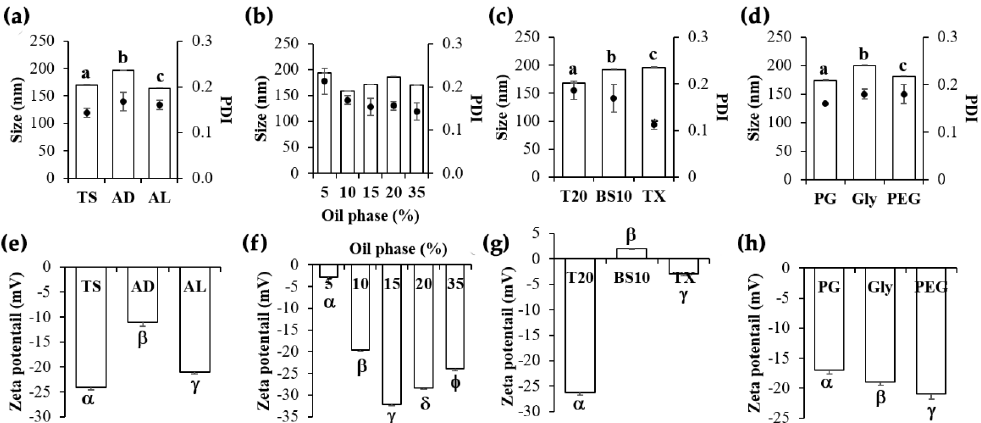
Figure 4. Particle size and polydispersity index (PDI) of nanoemulsion were developed using ( a ) di ff erent types of oils at the same concentration of 35% w / w , ( b ) various amount of oil phase, ( c ) di ff erent types of surfcatants at the same concentration of 7.5% w / w , and ( d ) di ff erent types of humectants at the same concentration of 7.5% w / w . Zeta potential of nanoemulsion were developed using ( e ) di ff erent types of oils, ( f ) various amount of oil phase, ( g ) di ff erent types of surfcatants, and ( h ) di ff erent types of humectants. Di ff erent types of oils included tea seed oil (TS), avocado oil (AD), and almond oil (AL). Di ff erent types of surfactants included Tween 20 ® (T20), Brij S10 ® (BS10), and Triton X-114 ® (TX). Di ff erent types of humectant included propylene glycol (PG), glycerin (Gly), and polyethylene glycol 400 (PEG). The letters, a, b, and c denote values that were significantly di ff erent in particle size ( p < 0.05), whereas the symbols, α , β , γ , δ , and φ denoted values that were significantly di ff erent in zeta potential ( p < 0.05).